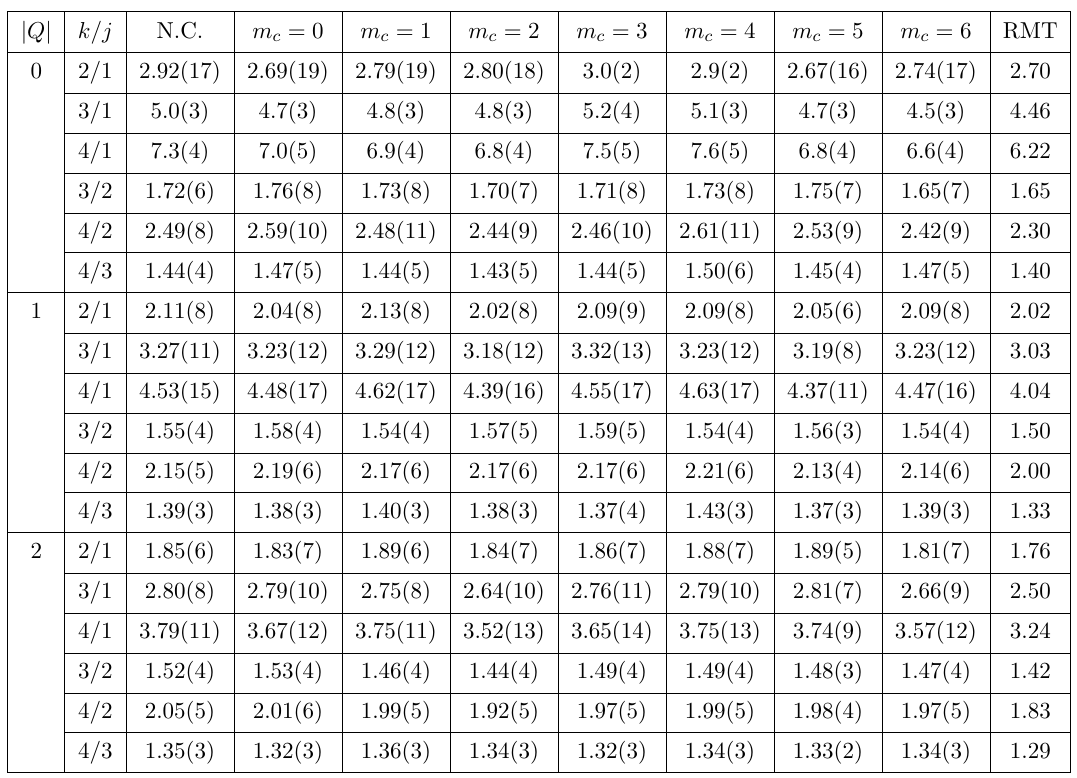
~ (cid:21) j Q j and the prediction. The normal con(cid:12)gurations (N.C.) and k i h ~ (cid:21) j i j Q j